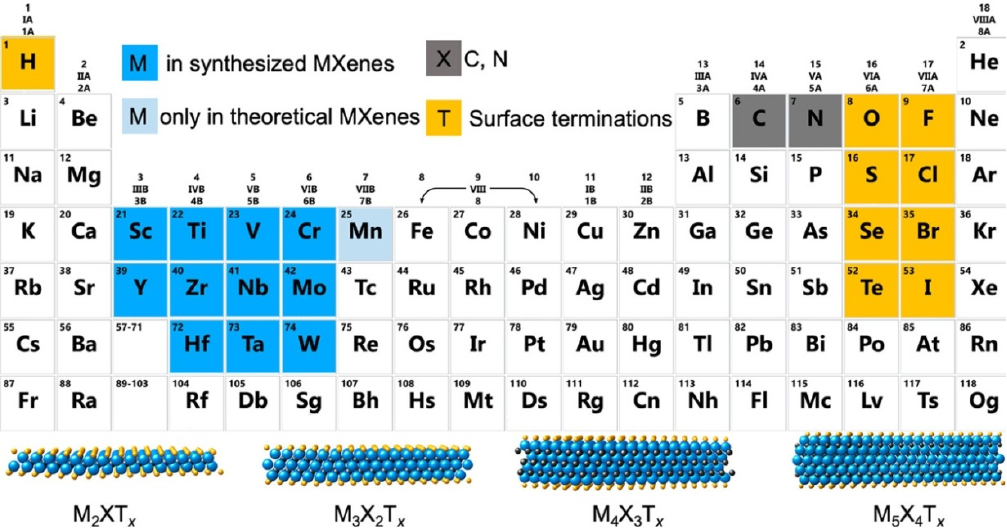
Figure 1. Schematics of the constituent elements of MXenes in the periodic table ( top ) and four typical molecular structures of MXenes (M 2 XT x , M 3 X 2 T x , M 4 X 3 T x and M 5 X 4 T x ) ( bottom ). Reprinted with permission from Ref. [24]. 2021, American Chemical Society.